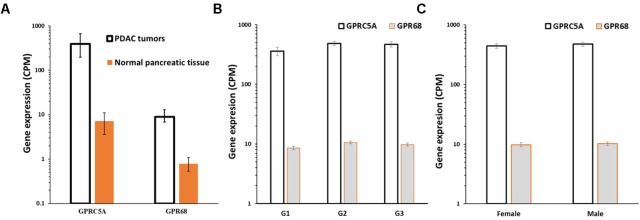
GPRC5A and GPR68 are highly expressed in PDAC tumors. (A) Median, upper and lower quartile expression values (indicated by the error bars) for GPRC5A and GPR68 in PDAC tumors (TCGA, n = 147) and in normal pancreatic tissue (GTEx, n = 165). In PDAC tumors, GPRC5A is increased ∼50-fold (FDR << 0.05) and GPR68 is increased ∼10-fold (FDR << 0.05). (B) Mean (and SEM) expression of GPRC5A and GPR68 in PDAC tumors (in TCGA) with tumor grades G1, G2, and G3. (C) Mean (and SEM) expression of GPRC5A and GPR68 in TCGA PDAC tumors from males and females. Expression differences for tumor grades and between males and females are not statistically significant.